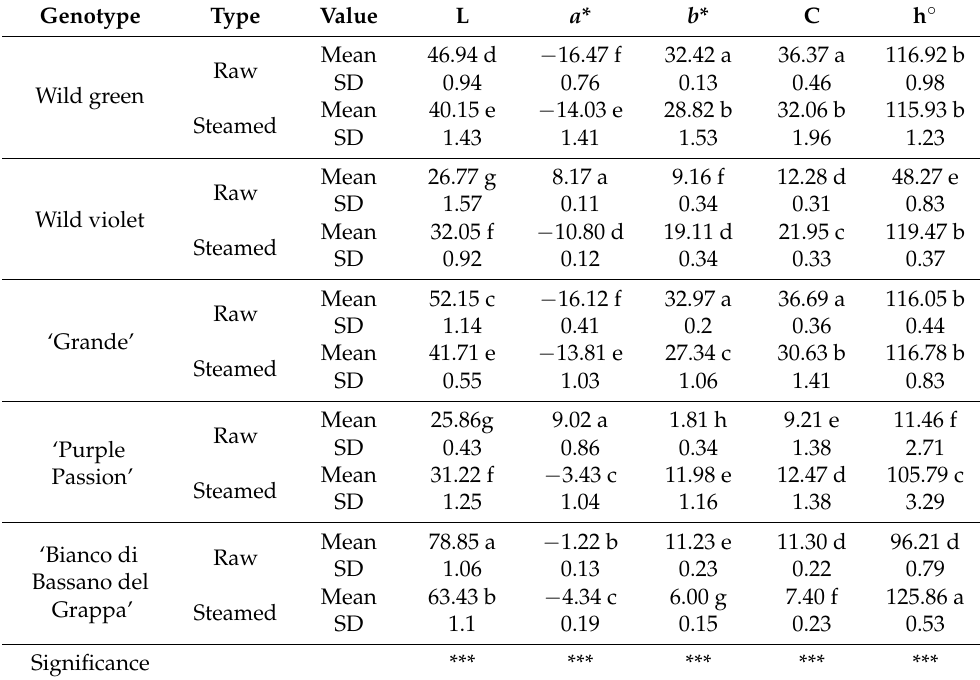
Table 2. Effects of steaming on color traits in different genotypes of asparagus. SD = standard